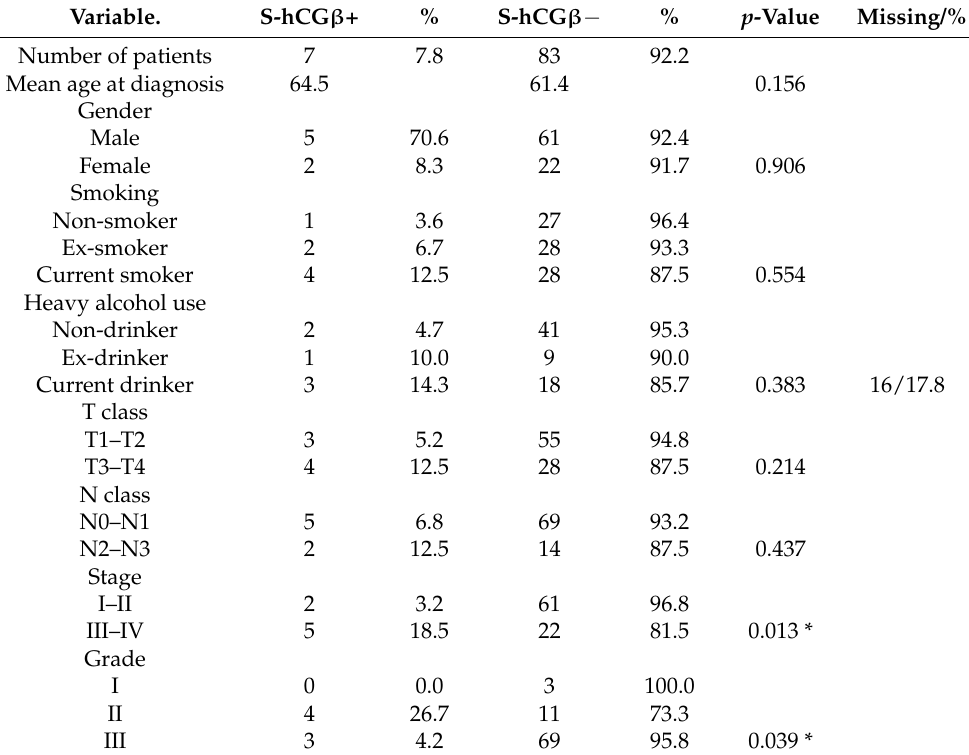
Table 1. Clinicopathological data according to positive (>2 pmol/L) and negative (<2 pmol/L) serum concentrations of hCG β (S-hCG β